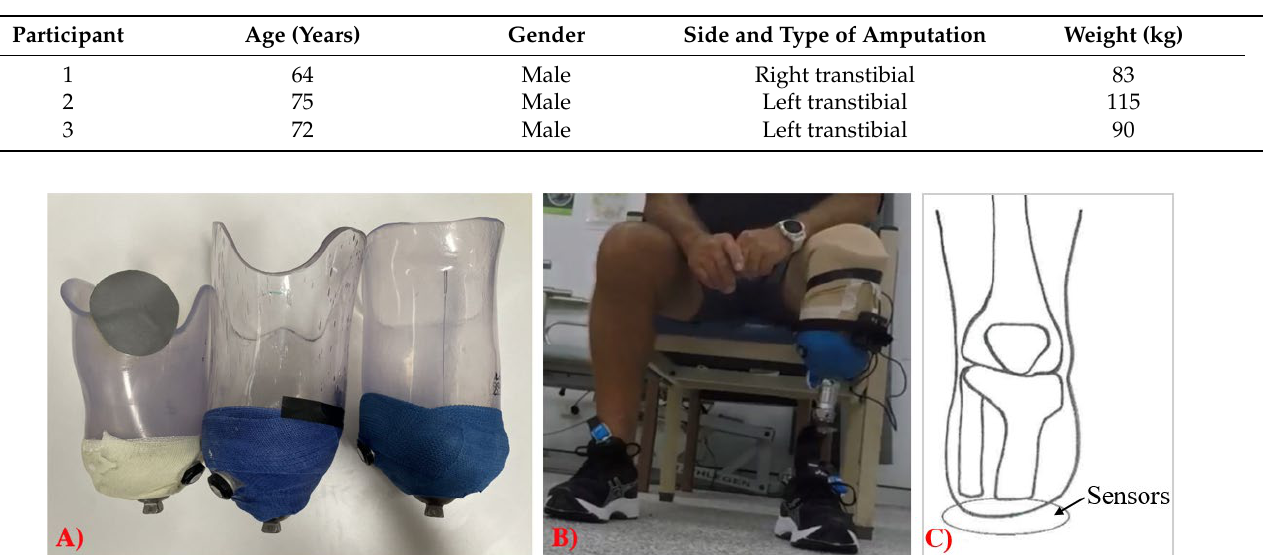
Table 2. Summary of participant demographics.